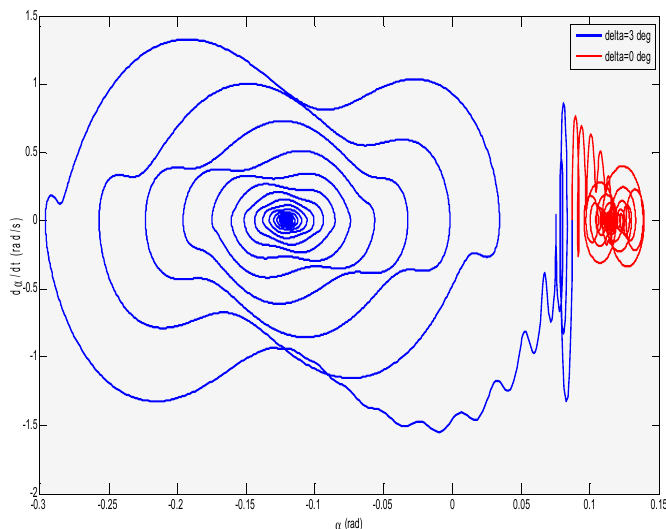
Figure 24. The state space response of alpha without freeplay and with 2 ◦ freeplay. (In lower speed of flutter).